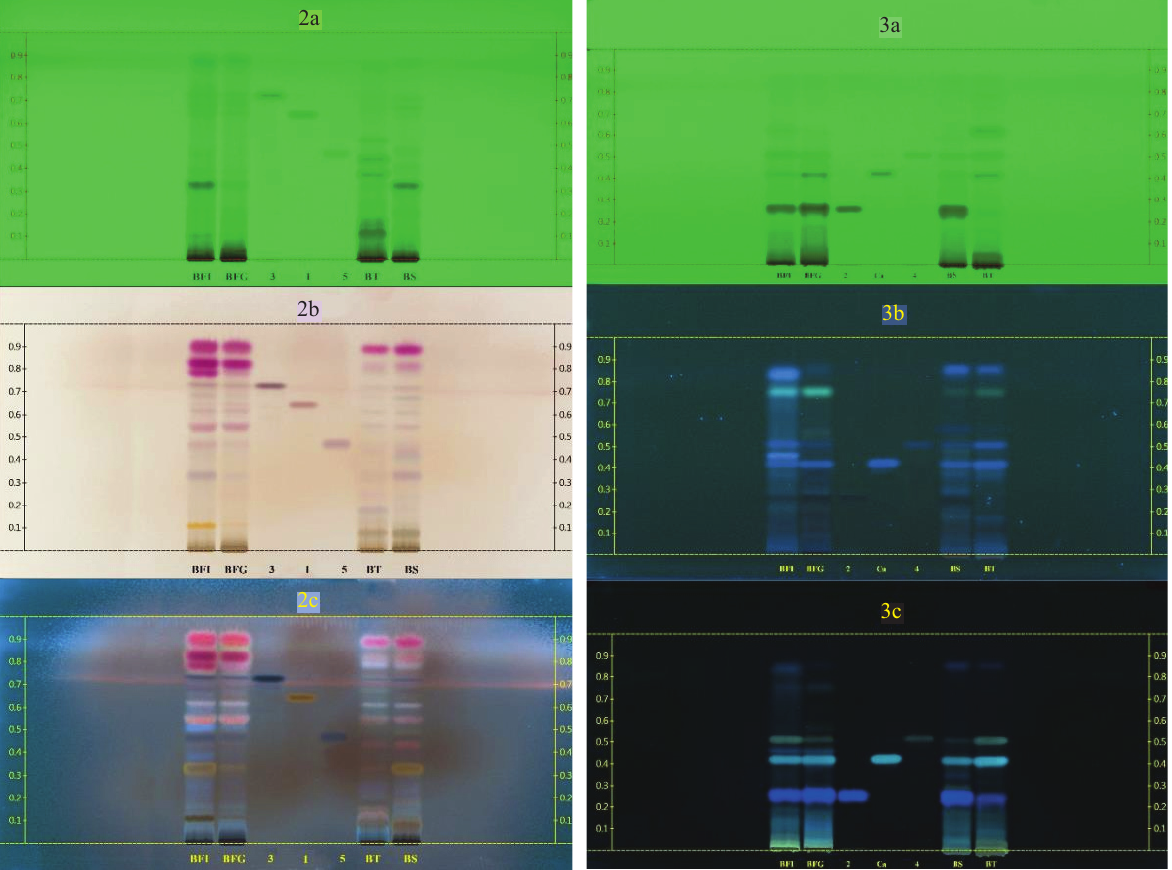
Fig. 2. Thin layer chromatogram developed with the eluent system (1) observed at λ = 254 nm (2a) before derivatiza tion, white light (2b) and λ = 366 nm (2c) after derivatization with anisaldehyde­sulphuric acid reagent (2c).